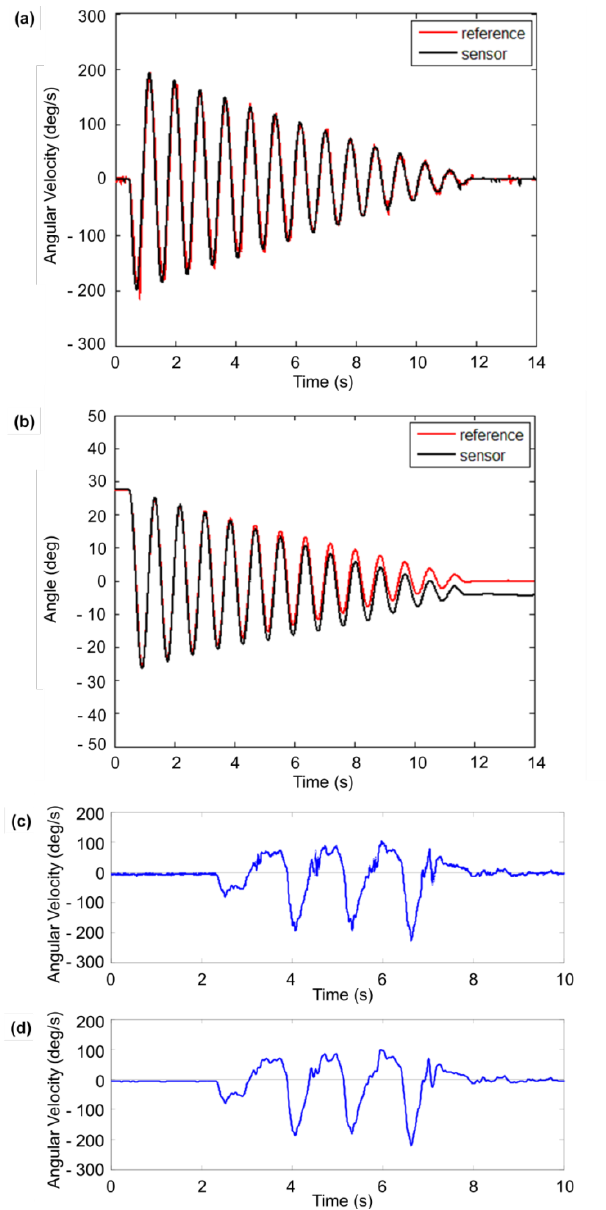
Figure 3. Sensor calibration results and signal filtering for noise reduction. ( a ) Comparison of the angular velocity results calculated from the gyro sensor and the reference CCD camera for a single link pendulum test. The vertical axis represents angular velocity while the horizontal axis represents the time. ( b ) Comparison of the pendulum link angle between gyro sensor and the CCD camera. The vertical axis represents angle while the horizontal axis represents the time. ( c ) A raw gyro sensor before any signal filtering. ( d ) The same gyro sensor data after applying an IIR digital Butterworth filter. The vertical axis represents angular velocity while the horizontal axis represents the time for both